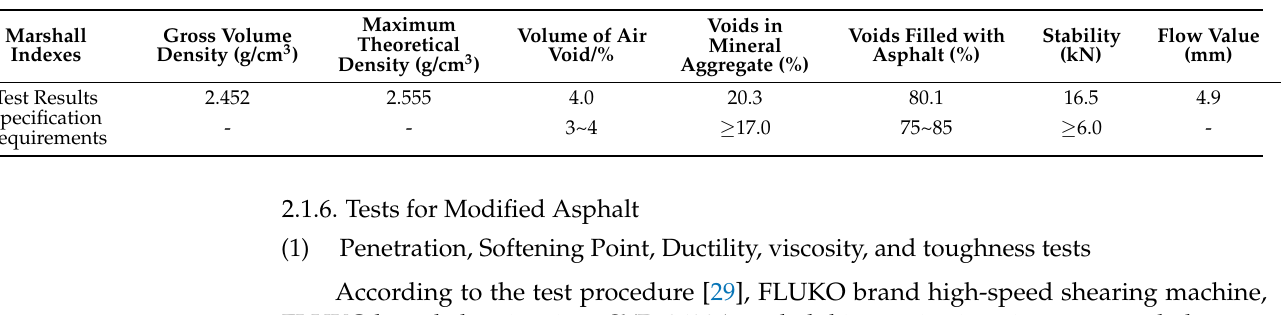
Table 6. SMA-10 Marshall test